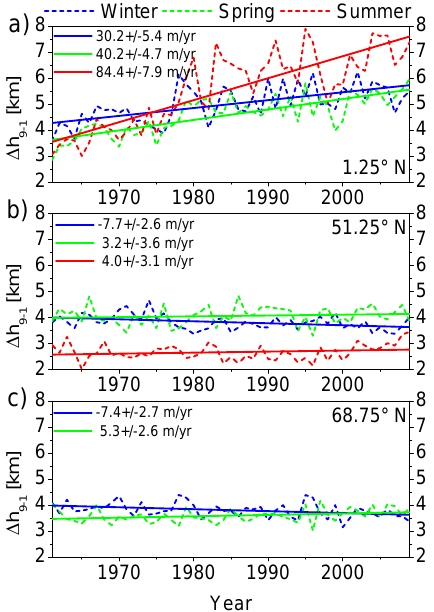
Figure 7. Trend of the distance of the OH ∗ layer for the three lati- tudes and seasons under investigation.